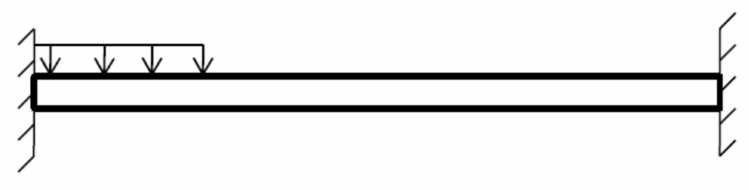
Figure 25. Clamped-clamped straight beam and